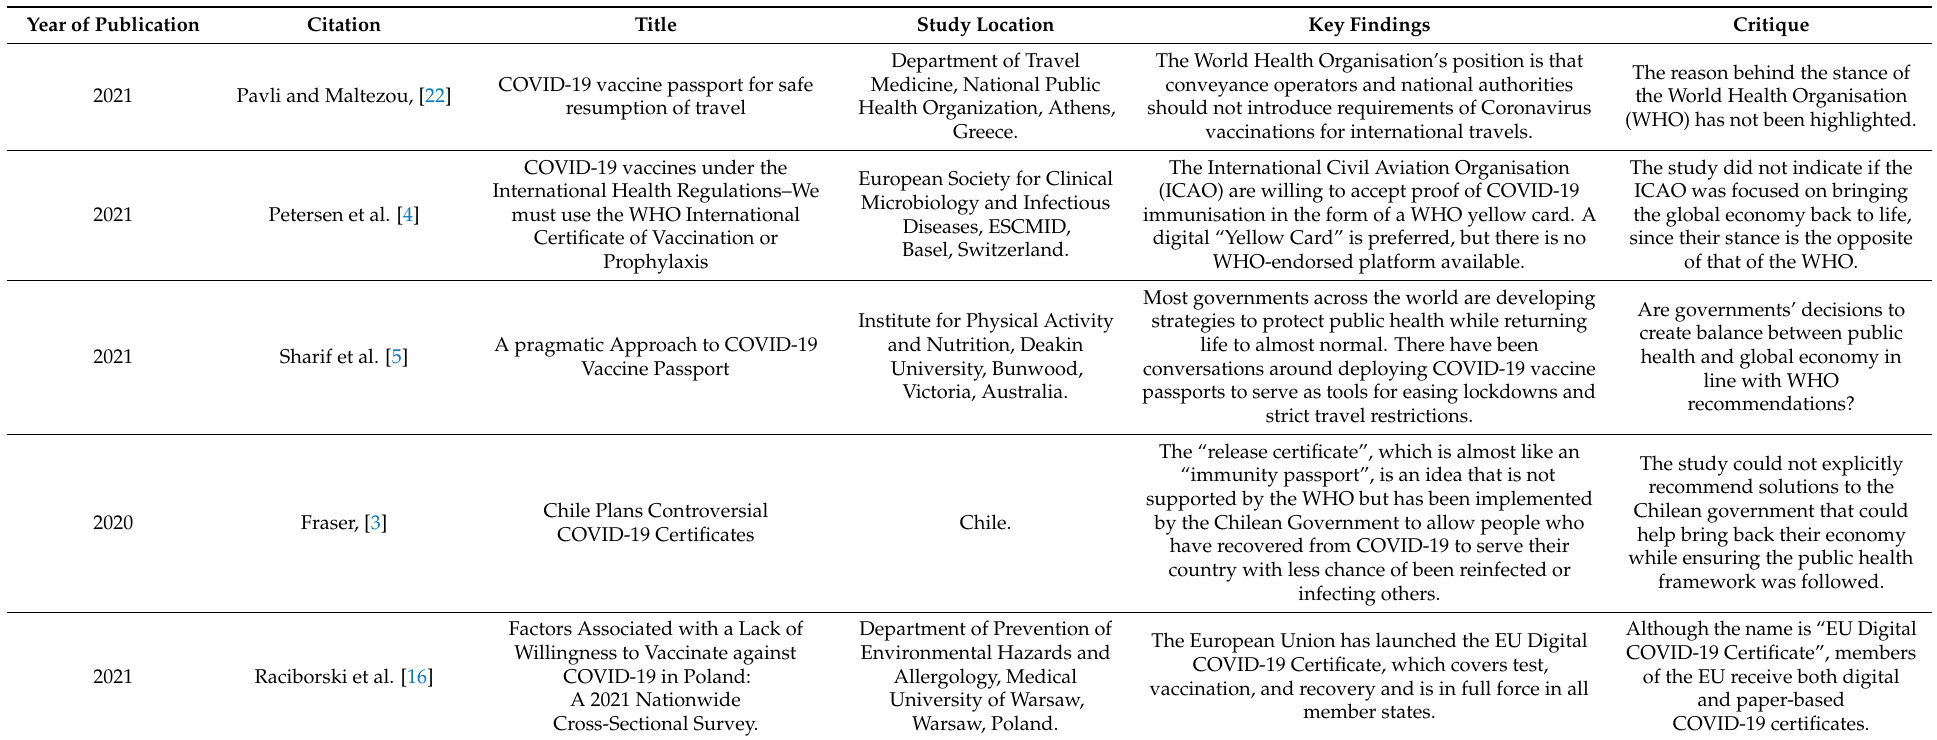
Table 7. Positions of stakeholders on COVID-19 vaccination